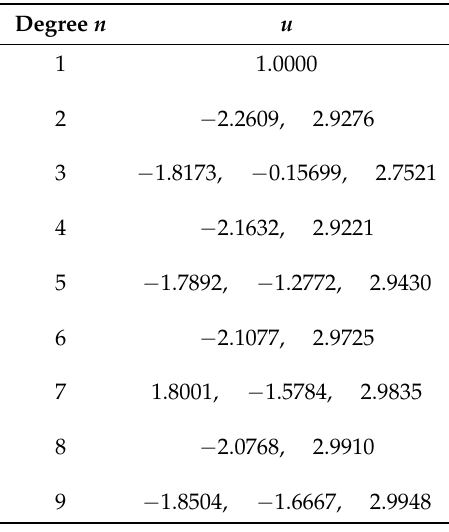
Table 6. Approximate solutions of C B